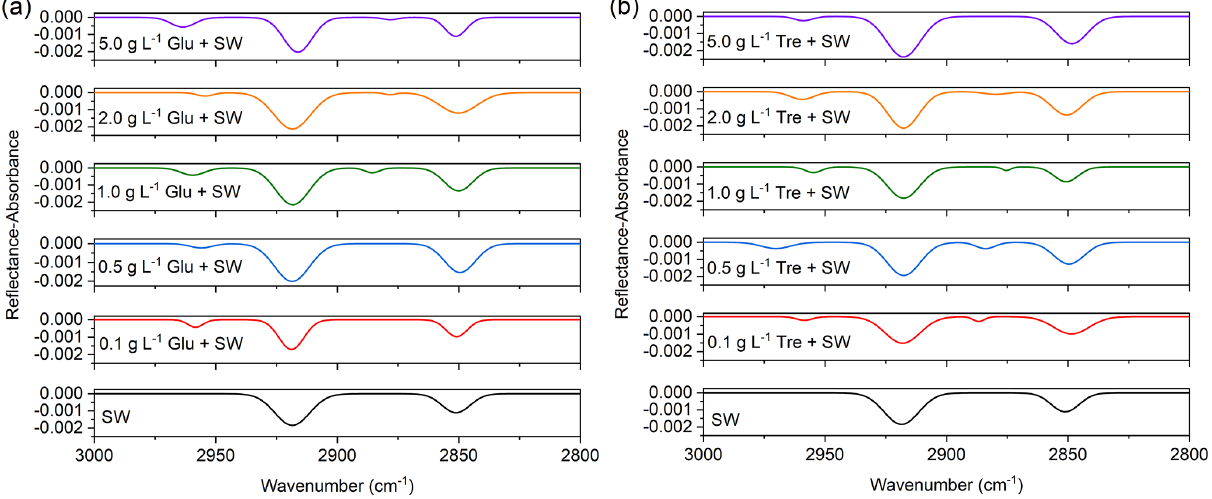
Figure 5. PM-IRRAS spectra (3000–2800cm − 1 ) of mixed fatty acids at the air/seawater interface at different (a) glucose and (b) trehalose concentrations in the